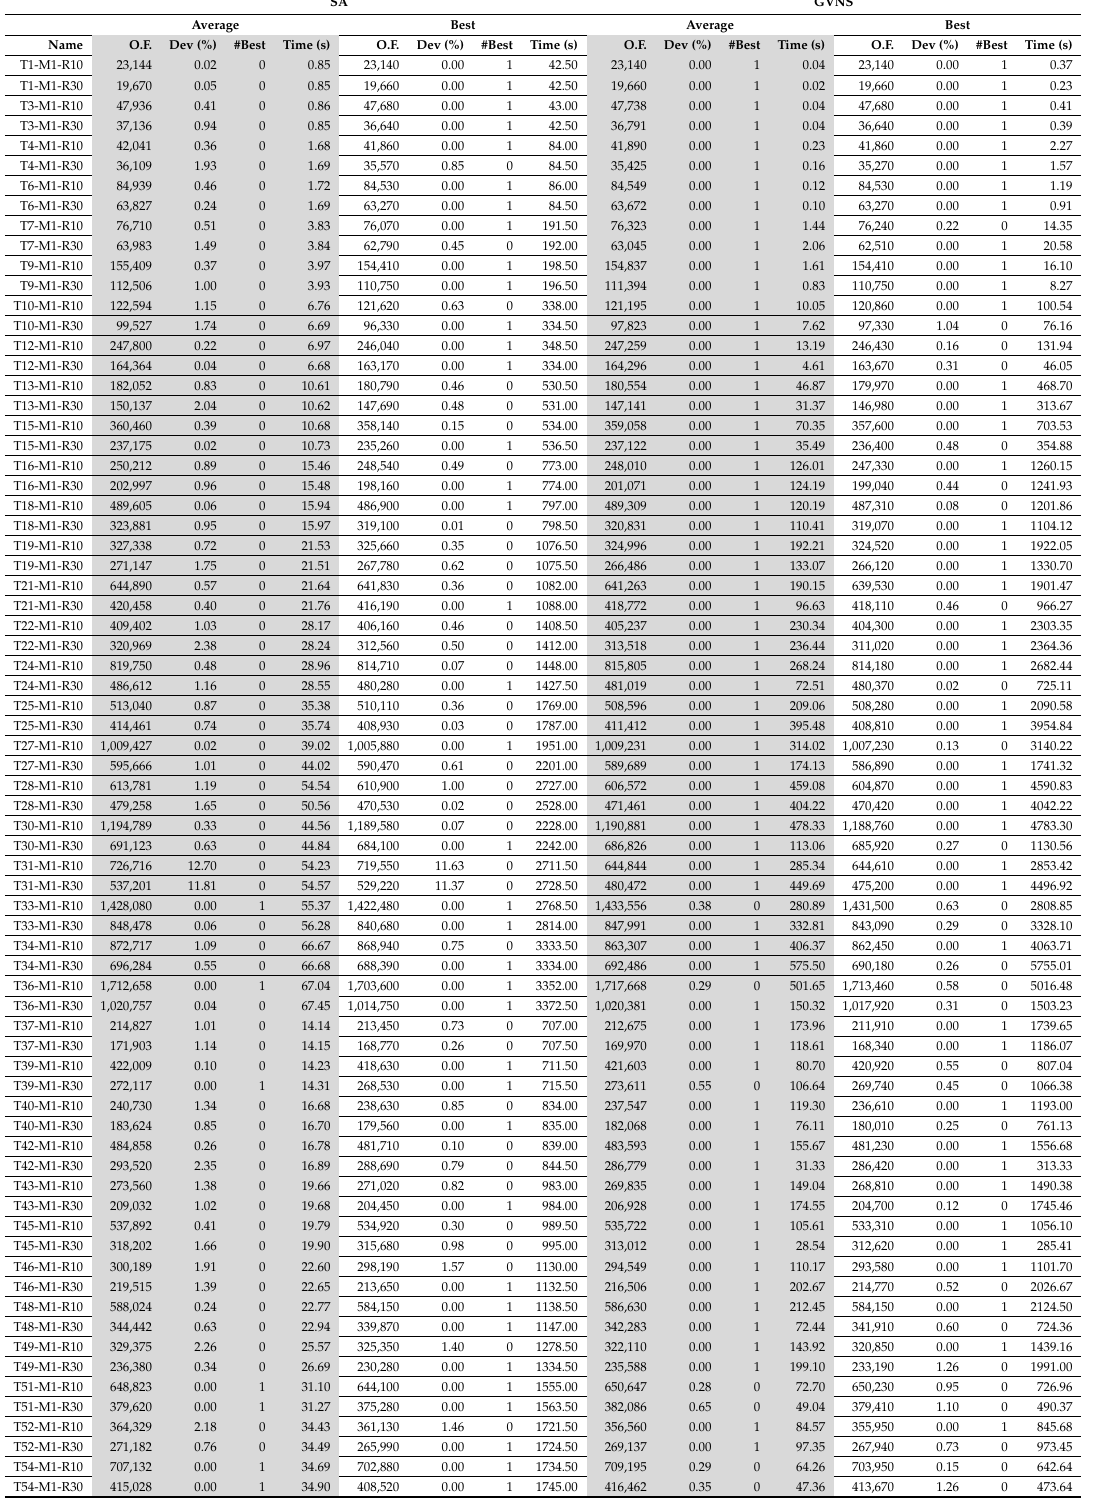
Table A1. Individual result for each